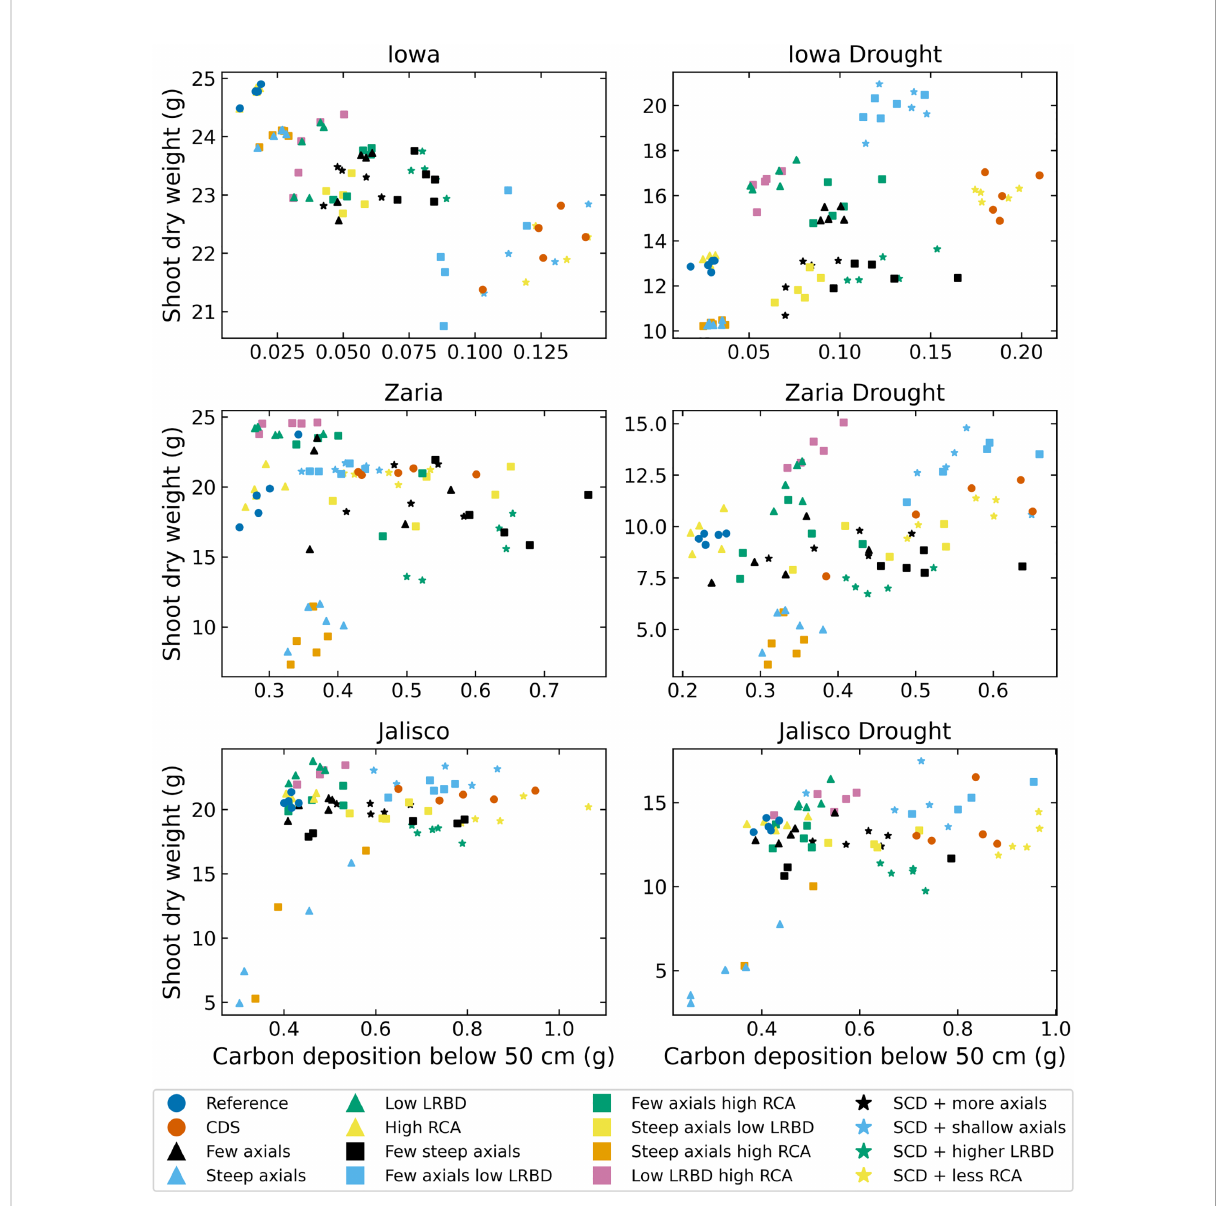
FIGURE 10 Carbon depositions below 50 cm deep in the soil versus shoot dry weight of all the maize phenotypes considered after 42 days in the 6 different environments. LRBD means lateral root branching density, RCA means root cortical aerenchyma and SCD refers to the steep, cheap, deep